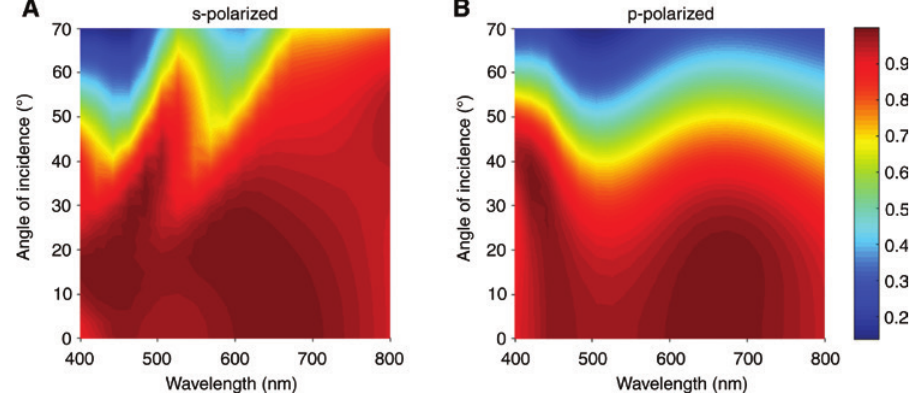
Figure 3: Electromagnetic simulation for absorption change according to incident angle.